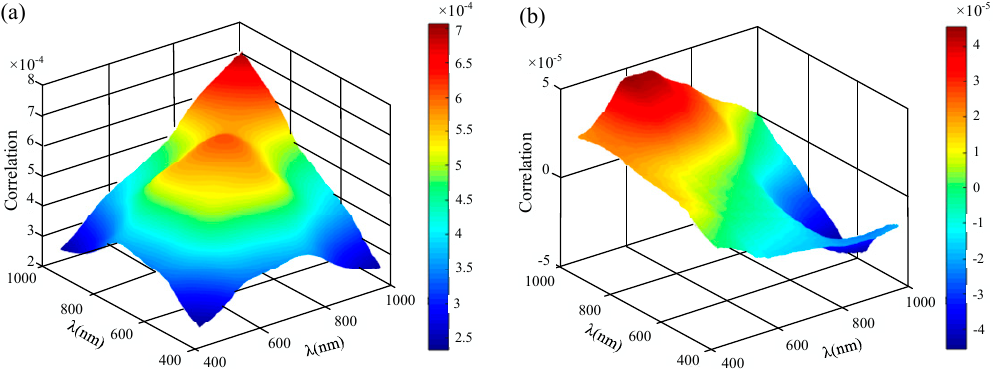
Figure 10. Two-dimensional correlation spectrum of dust. ( a ) Synchronous spectrum, ( b ) asynchronous spectrum.